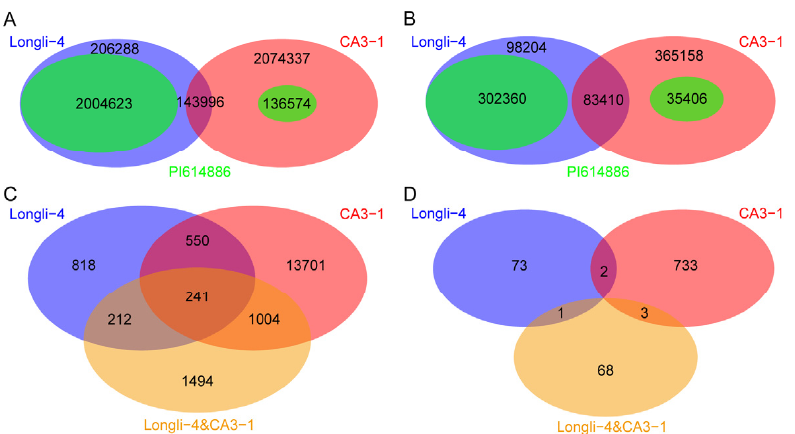
Figure 5. Genetic variations between Longli-4 and CA3-1. ( A , B ) Numbers of SNPs ( A ) and INDELs ( B ) between Longli-4 and CA3-1. The variety-specific SNPs and INDELs for Longli-4 and CA3-1 are shown in blue and red, respectively. Blue + red represents the shared SNPs (143,996) or INDELs (83,410) between Longli-4 and CA3-1. Green indicates that the SNP or INDEL variations have the same genotype between one variety and the reference line PI614886. ( C , D ) Genes with pairwise non-synonymous SNPs and INDELs variation ( C ) and stop-gain SNPs variation ( D ) between